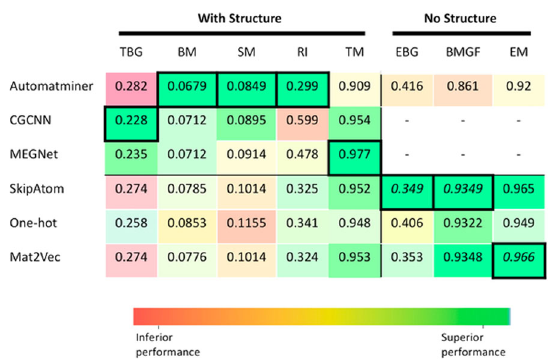
Bold value represents the best result. All results were generated using the same procedure on identical train/ test folds.